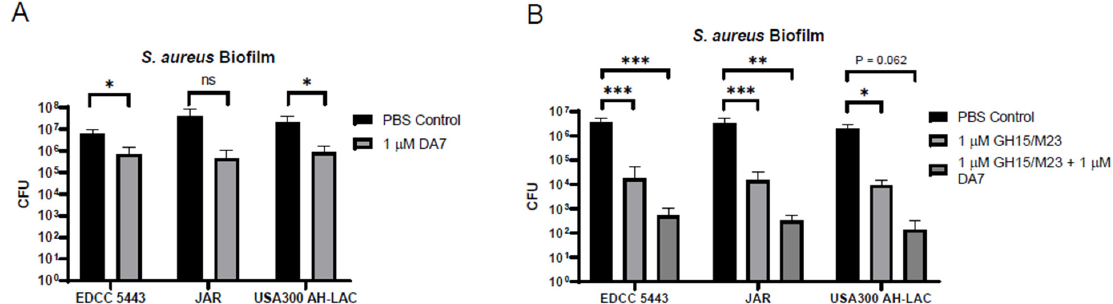
Figure 2. The DA7 polysaccharide depolymerase enhances the antibiofilm effects of peptidoglycan hydrolases (lysins). ( A ) Measurement of biofilm eradication using a 96-well peg lid model of the three indicated S. aureus strains after treatment with DA7 polysaccharide depolymerase ( n = 3). ( B ) Biofilm eradication as in ( A ) comparing lysins (GH15 and M23) to lysins combined with the DA7 depolymerase ( n = 5 for control and lysins; n = 3 for lysins + depolymerase). *** p ≤ 0.001, ** p ≤ 0.01, * p ≤ 0.05, ns: p > 0.05.